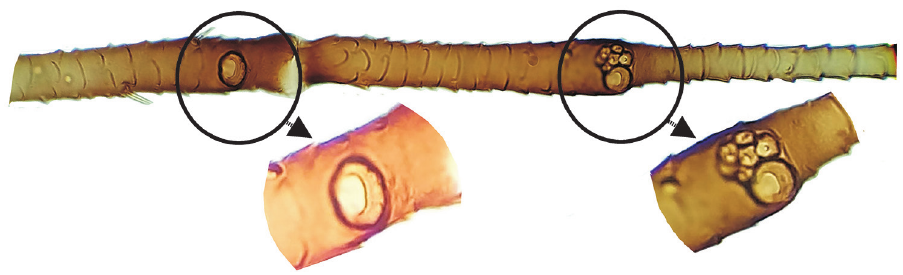
Figure 4. Delfinoia peruviana (Essig) apterous viviparous female. Antennal segments V and VI, in part, showing primary and satellite (on VI)